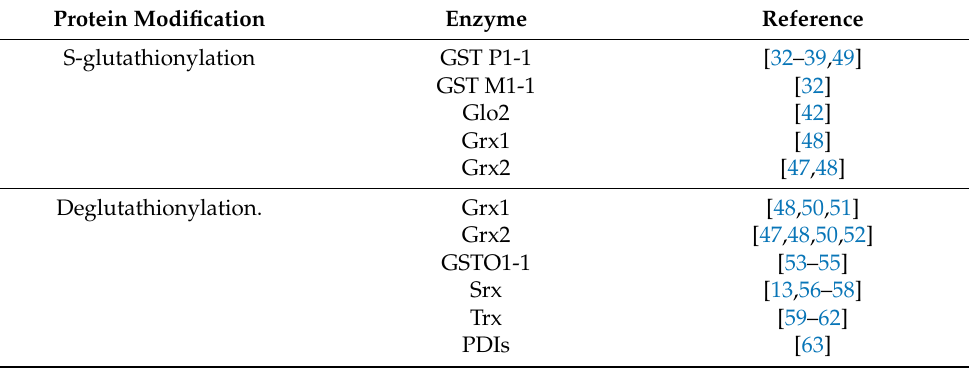
Table 1. Enzymes with capacity to catalyze S-glutathionylation and deglutathionylation. Protein